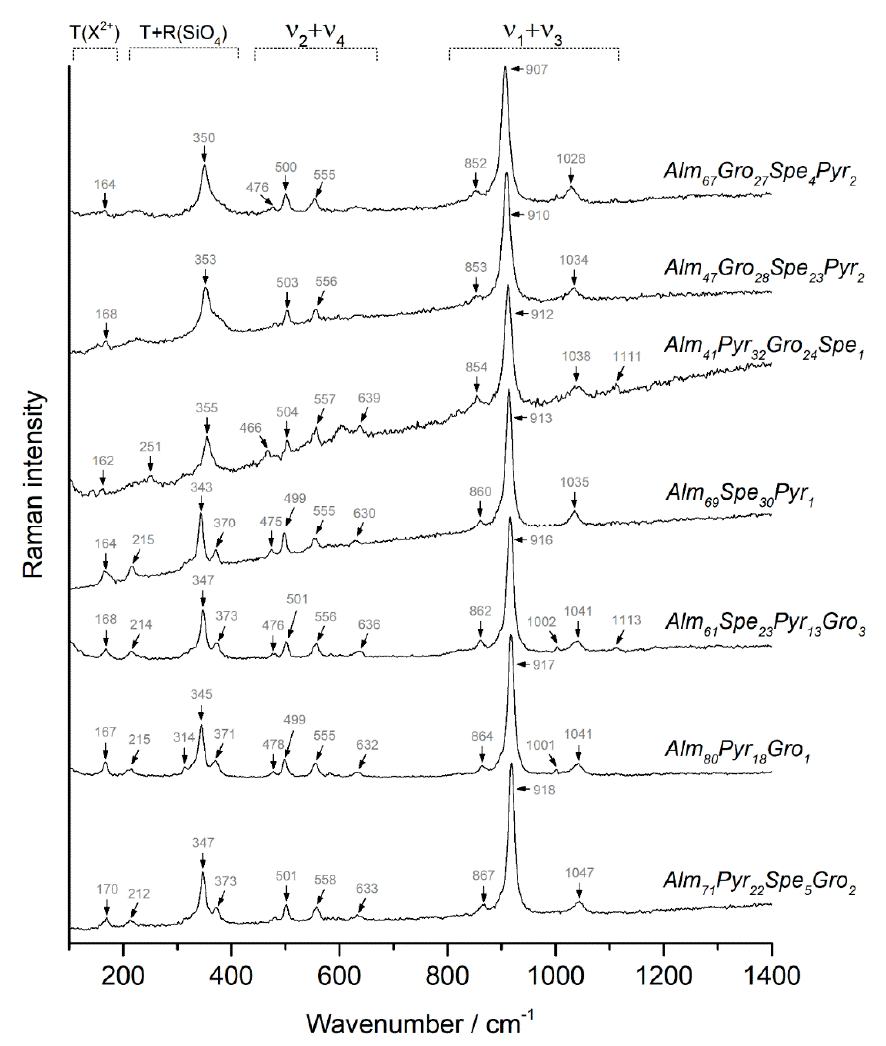
Figure 1. Representative Raman spectra of various garnet compositions and band assignments.